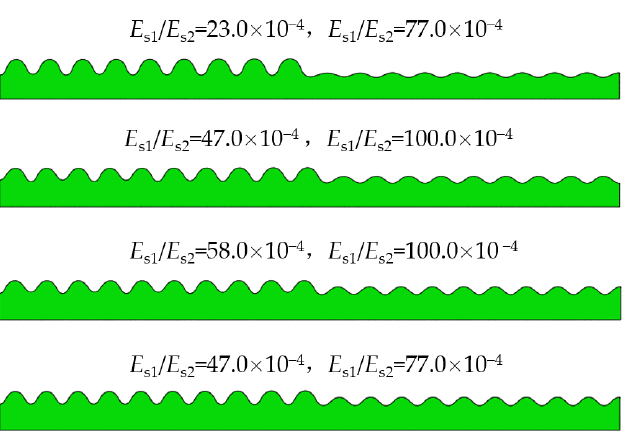
/ E s on the composite instability morphology. 1 2 / E s . 1 2